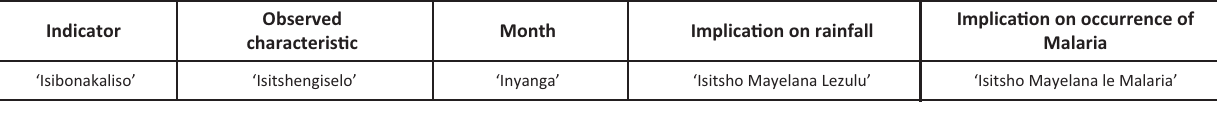
FIGURE 6: Format for documentation of indigenous knowledge systems indicators for the occurrence of malaria.